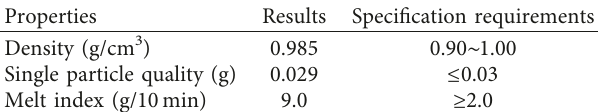
Table 5: Properties of the high-viscosity agent